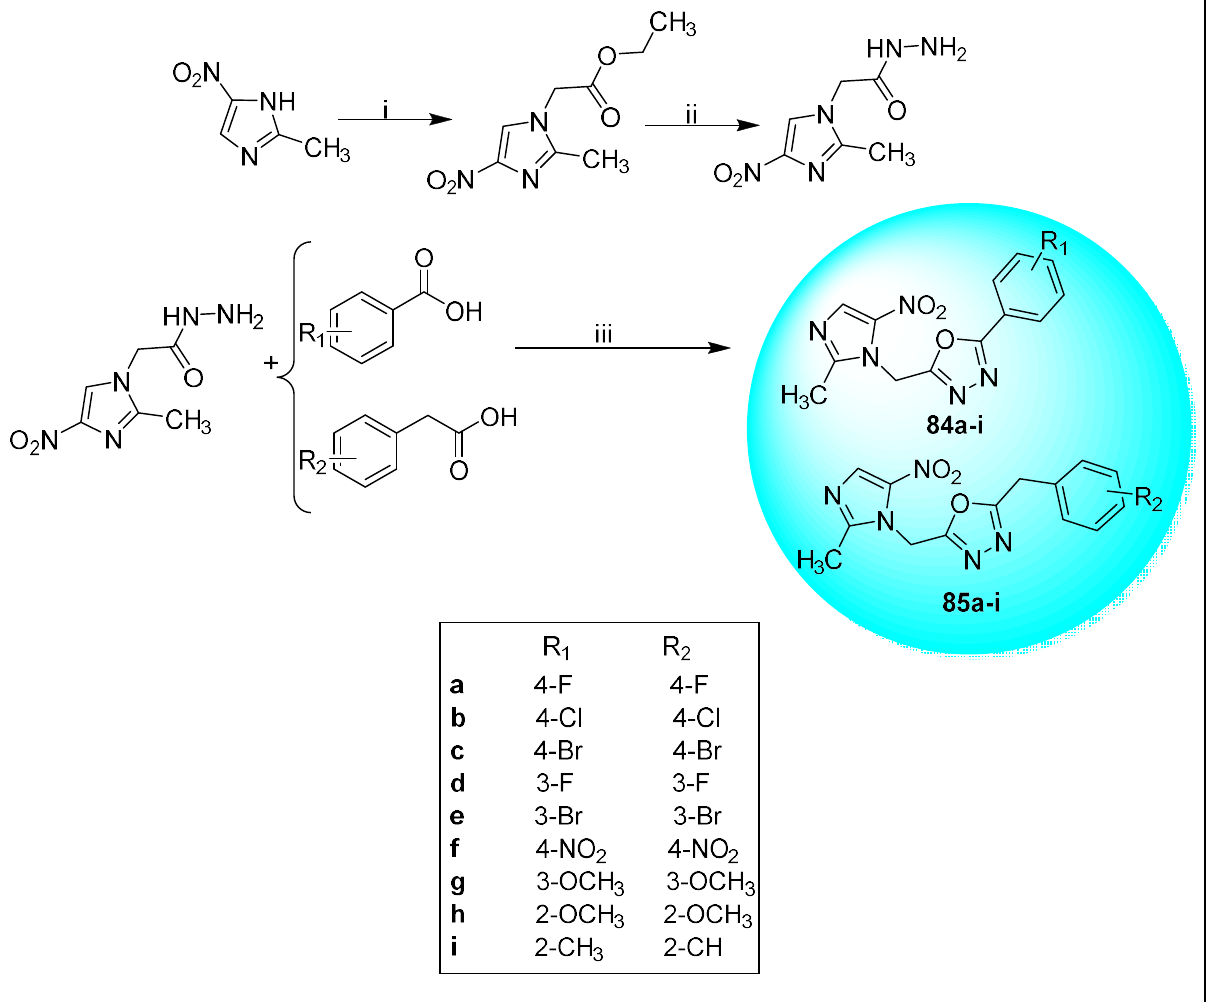
Scheme 25. Synthesis of 4-nitroimidazole derivatives with antibacterial activity. Reagents and conditions: ( i ) ClCH 2 COOC 2 H 5 , K 2 CO 3 , acetone; ( ii ) H 2 NNH 2 .H 2 O, MeOH; ( iii ) POCl 3 (yields